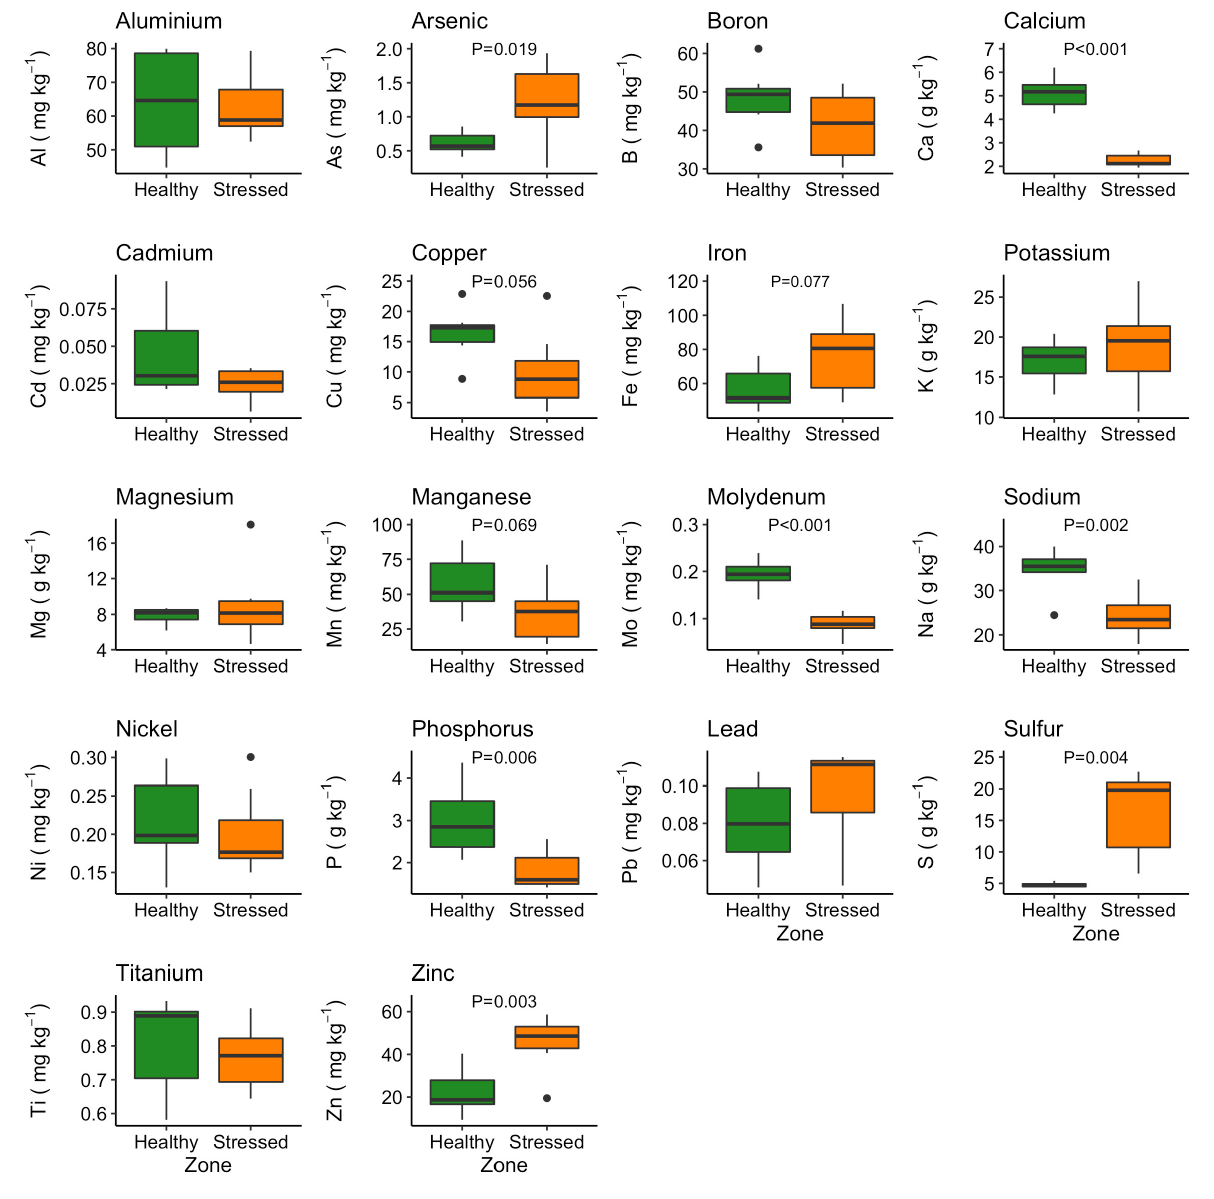
FIGURE 10 | Variation in leaf nutrients between “stressed” and “healthy” Avicennia marina at the St Kilda mangrove forest, South Australia. The analyses were done on the second youngest leaves. Four leaves were sampled from each of seven plants per zone. P -values are only shown for significant